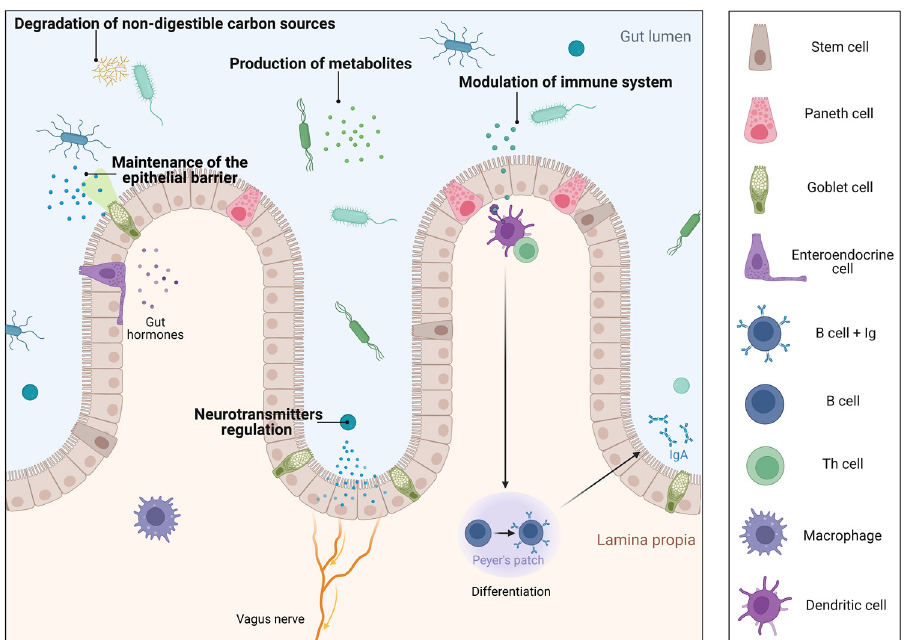
Figure 1. Specific gut microbiota functions. Gut microbiota impacts on host nutrient metabolism through the degradation of non-digestible carbon sources and the synthesis of metabolites, mainly SCFAs and vitamins. Additionally, it plays an essential role in the protection against pathogens in two ways, firstly by its participation in the maintenance of the structural integrity of the gut mucosal barrier. Secondly, through the modulation of the immune system, it stimulates lymphocyte B differentiation and the consequent release of IgA to the gut lumen. Finally, microbiota can also participate in neurotransmitter regulation and exert a beneficial effect on the nervous system. Created with BioRender.com. Accessed on 1 October 2022.